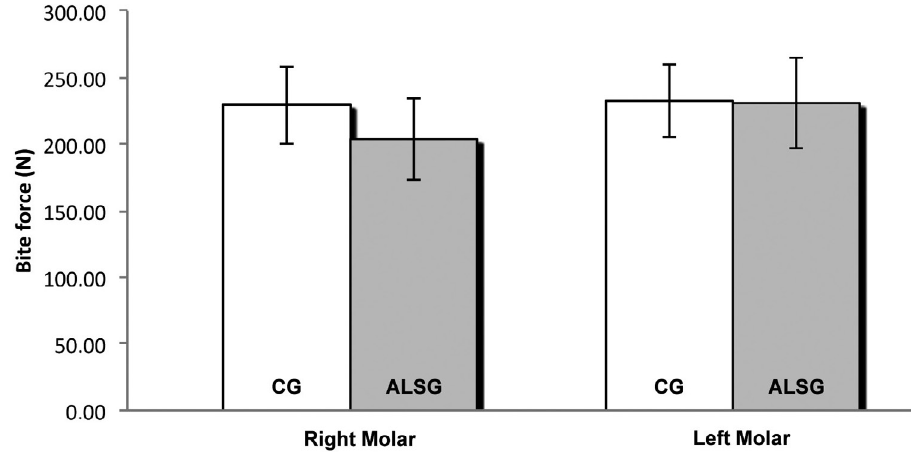
Figure 11- Maximum molar bite force data of CG and ALSG (right molar and left